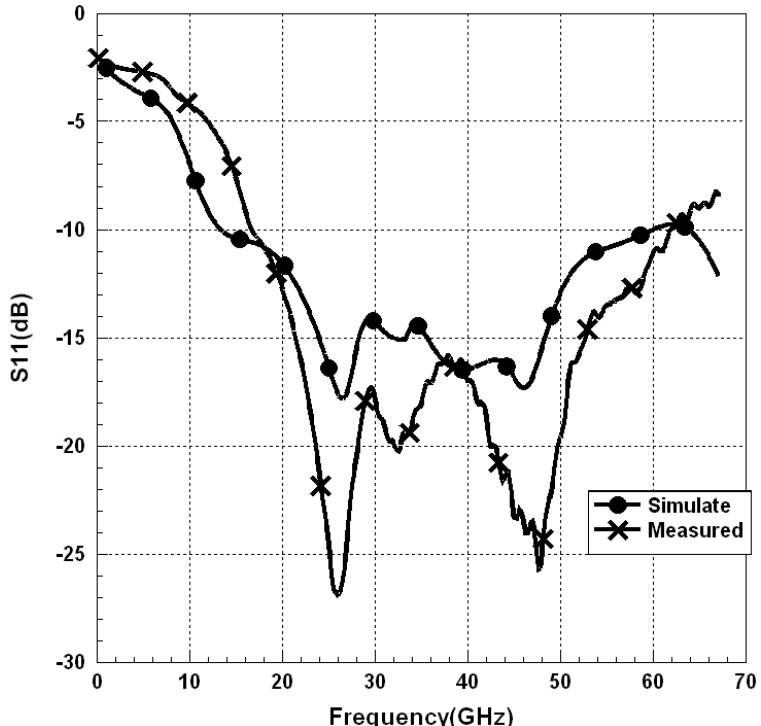
Figure 23. The proposed chip measurement results are compared with the simulated results.